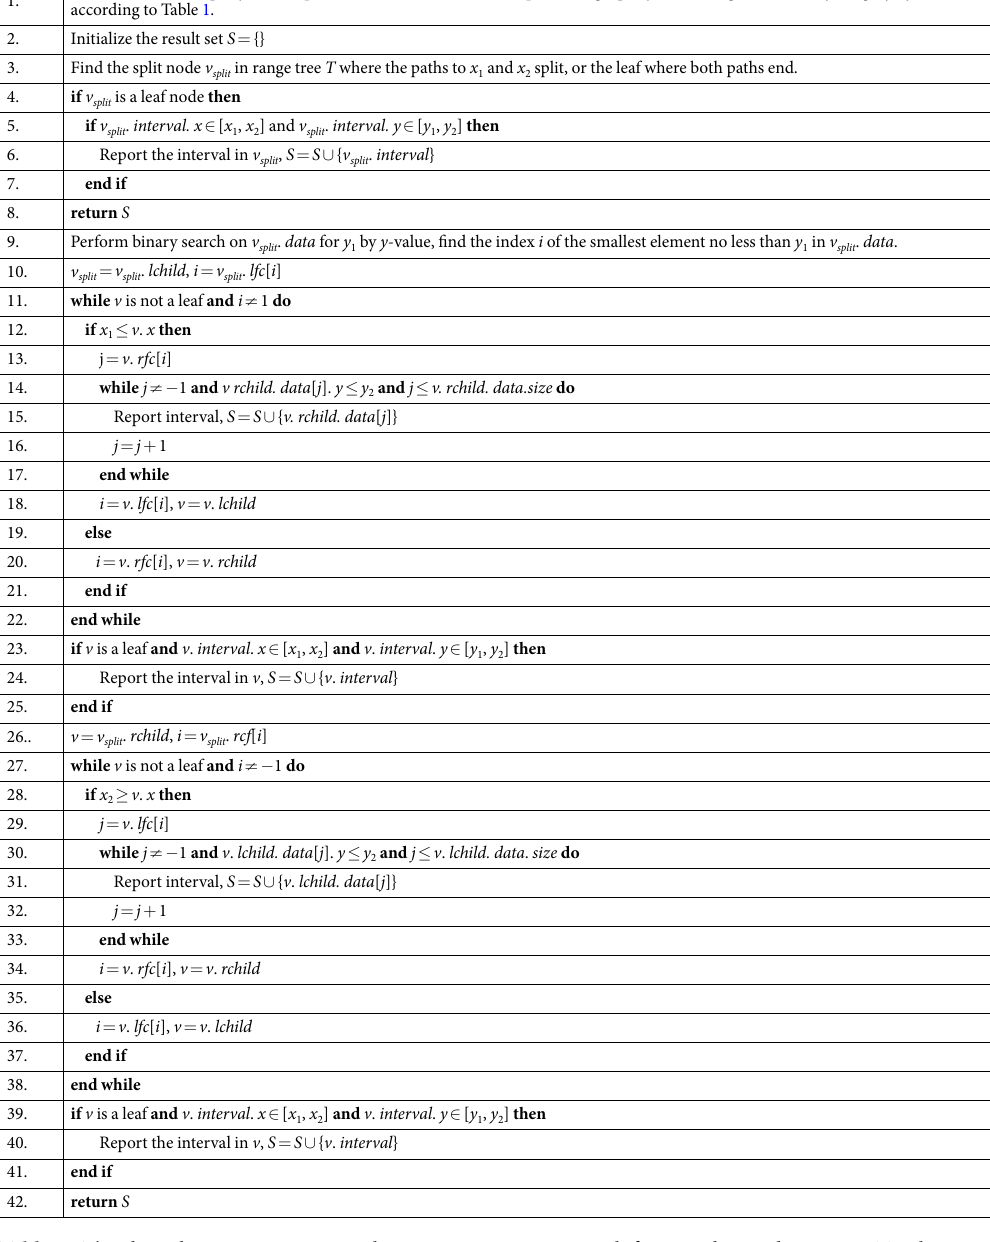
Table 3. The algorithm to execute interval query using range tree with fractional cascading. Input T is the range tree; I is the query interval; R is the relationship. Return the result interval set S corresponding to all the intervals in range tree T satisfying the relationship R with interval I